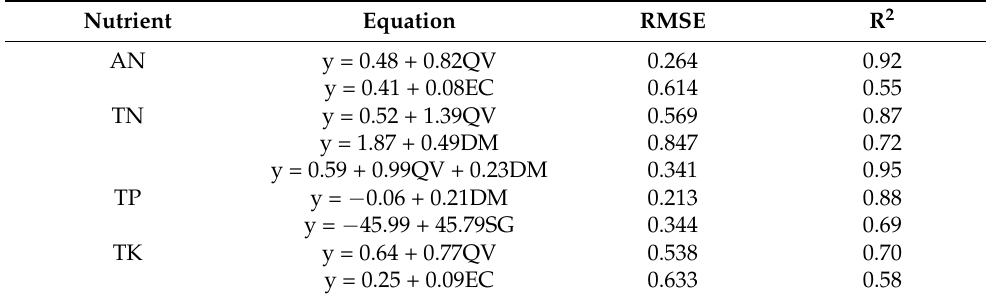
Table 2. Regression models for the total dataset (n = 391) with coefficients of determination (R 2 ) and RMSE (significance level for all regressions p <